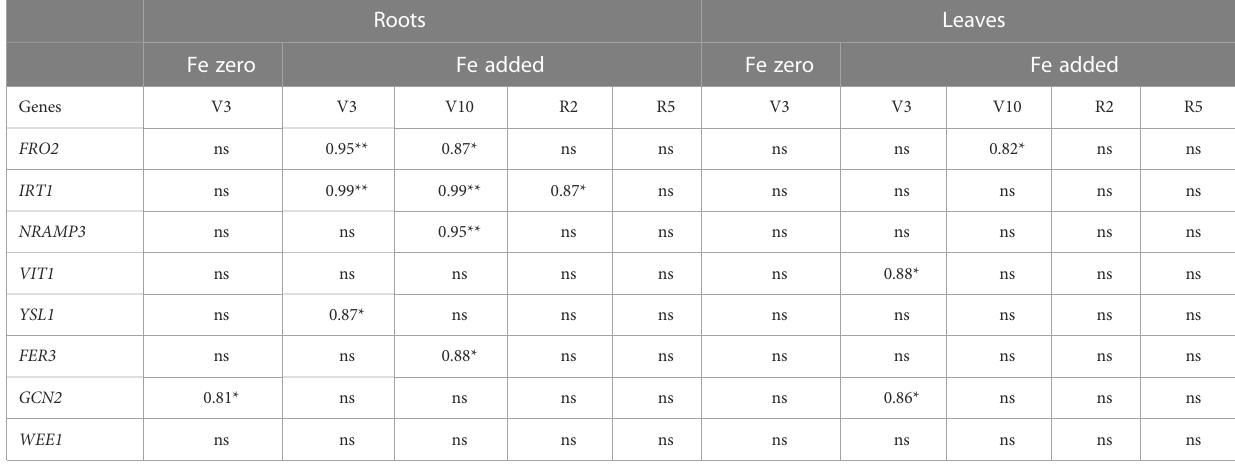
TABLE 4 Correlation between Fe concentration and gene expression in roots and leaves at V3 to R5 growth stage of six genotypes grown under Fe zero and Fe added